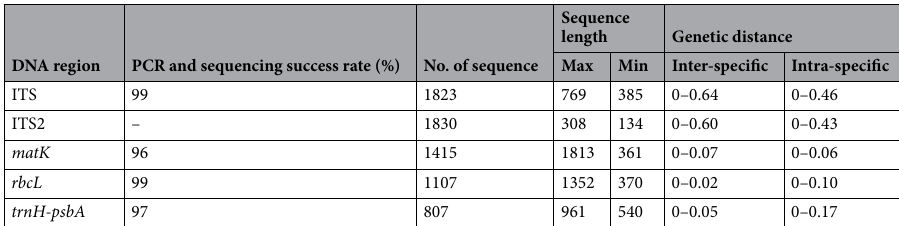
DNA region PCR and sequencing success rate (%) No. of